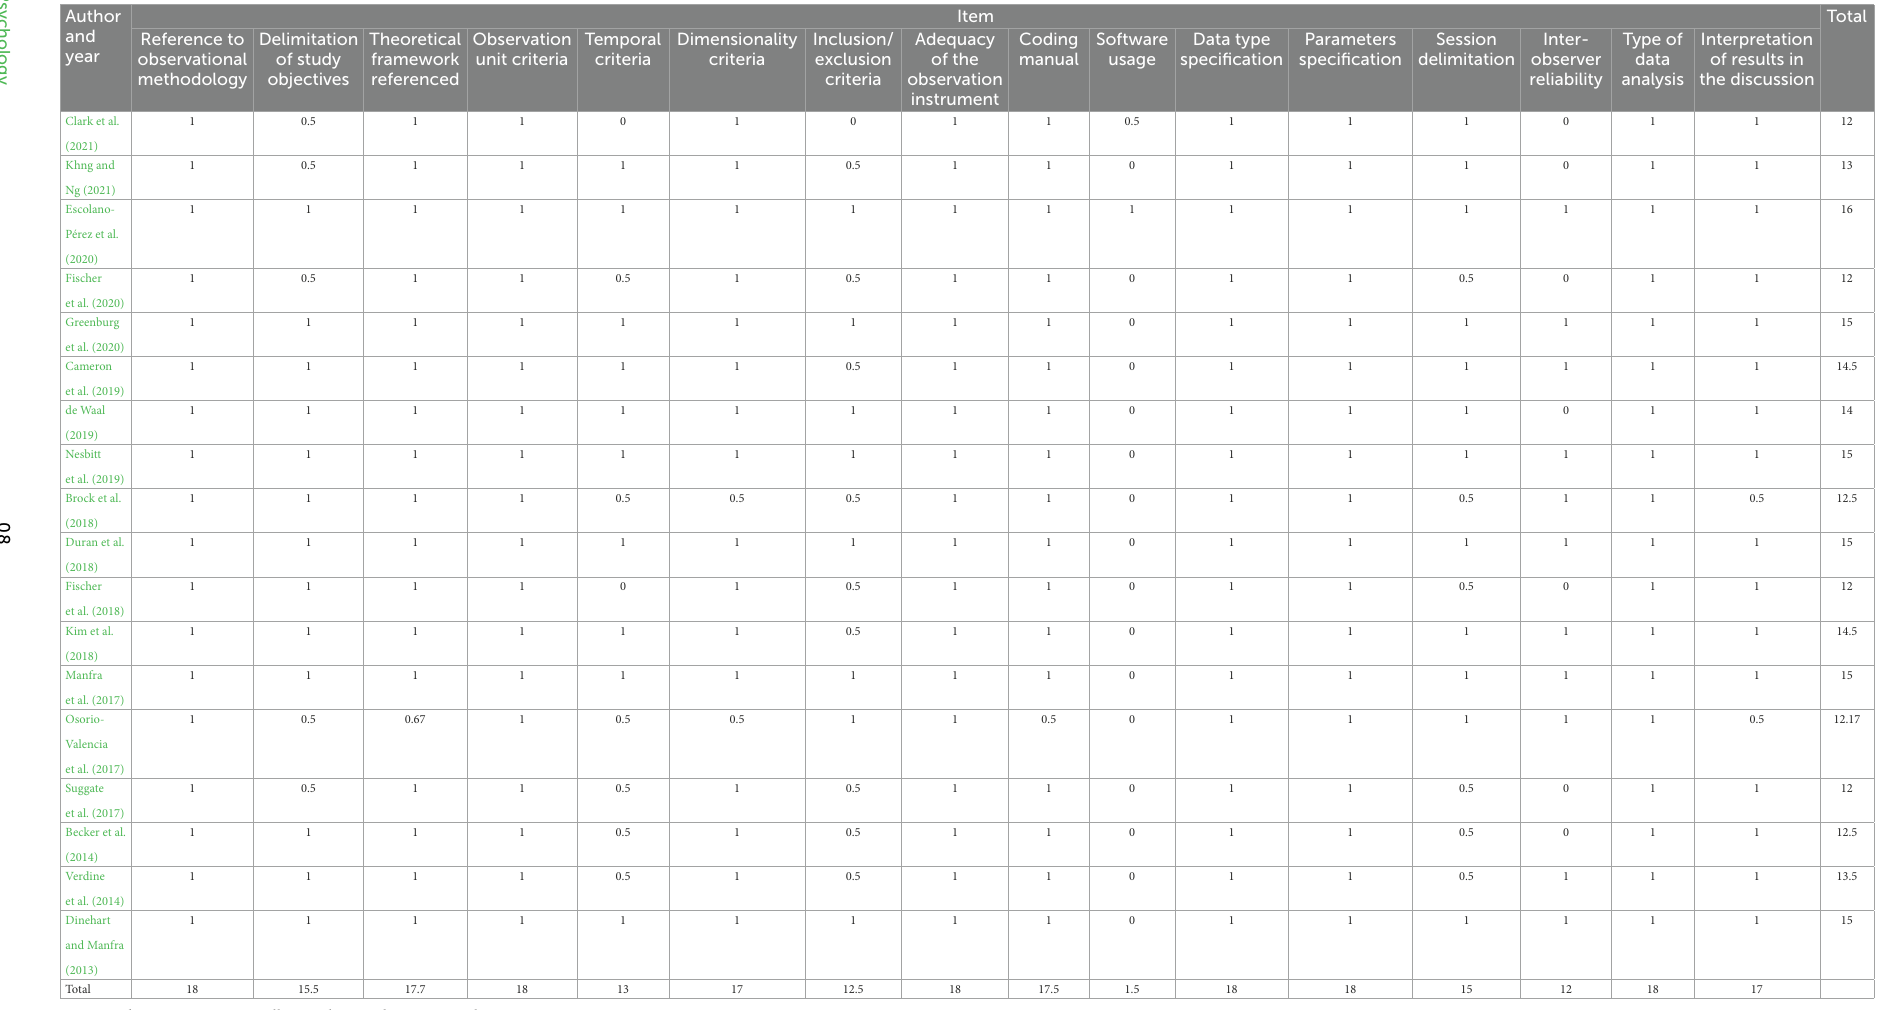
TABLE 1 Methodological characteristics observed using the Methodological Quality Checklist for studies based on Observational Methodology